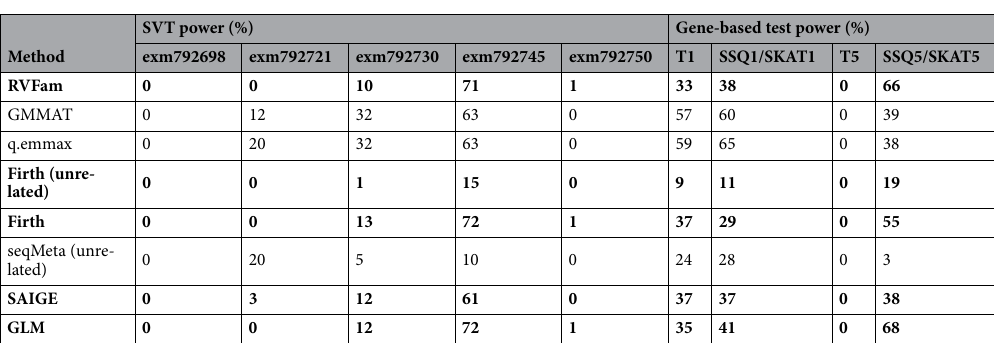
Table 3. Power analysis results of the first simulation study. Methods in bold are those not having severe inflation in type I error study and thus whose power can be compared together. Genome-wide significance level for single variant tests (SVT) = 2.027E−7; for Gene-based tests = 1.876E−6. Methods with “unrelated” are those applied to unrelated samples, all other approaches were applied to related samples. T1/T5, SSQ1/SSQ5 and SKAT1/SKAT5 denote the three gene-based tests with MAF threshold 0.01/0.05, collapsing/burden test, sum of squares test and SKAT,